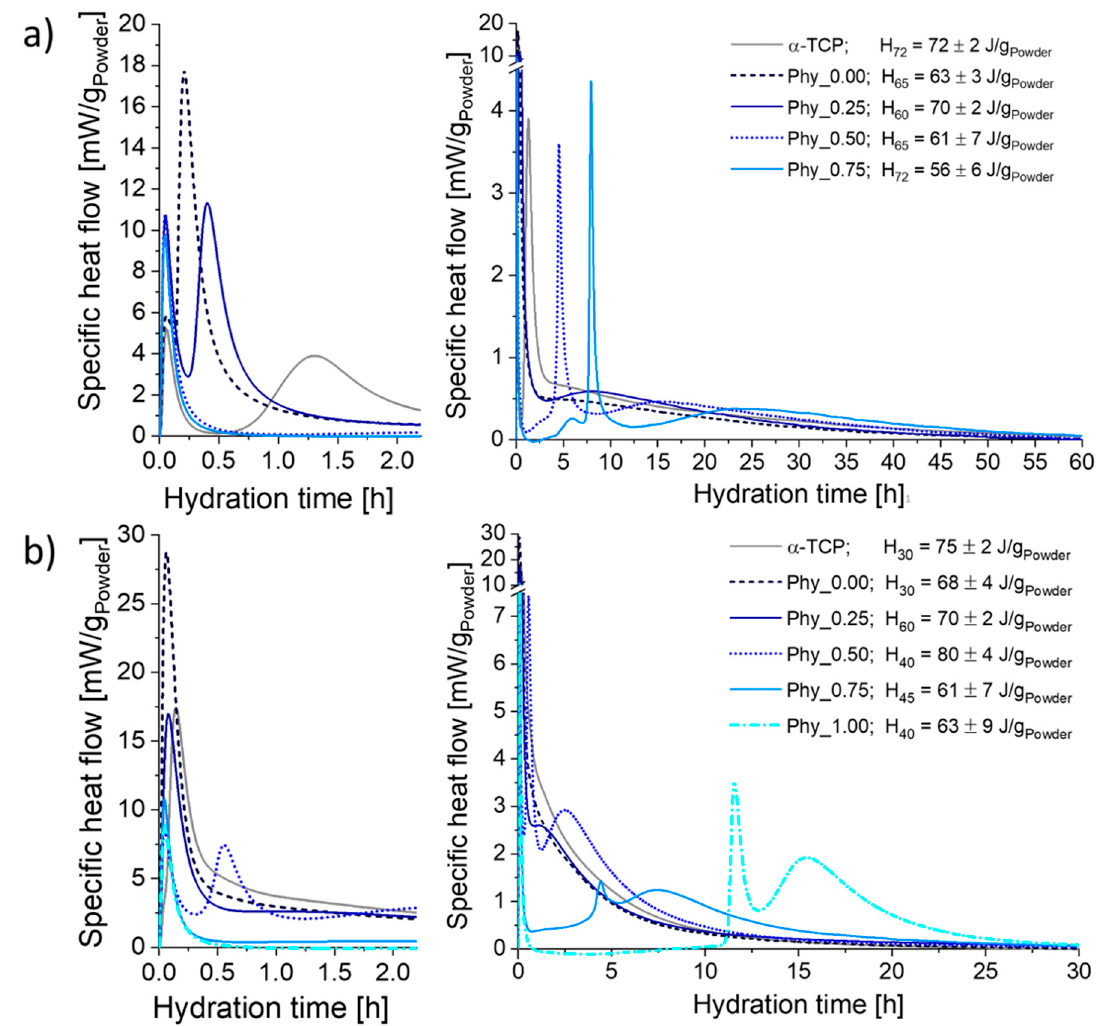
Figure 5. The calorimetry results of the samples composed of α –TCP and CDHA (weight ratio 9:1) with different amounts of sodium phytate; a 0.2 M Na 2 HPO 4 solution was used as the mixing liquid with an L/P of 0.3 ml/g Powder . The measurements were performed at ( a ) T = 23 °C and ( b ) T = 37 °C; three independent measurements were run for each sample; one representative curve is shown for Phy_0.75 at T = 23 °C and for Phy_0.50, Phy_0.75 and Phy_1.00 at 37 °C, and for the other samples the mean of three independent measurements is presented.